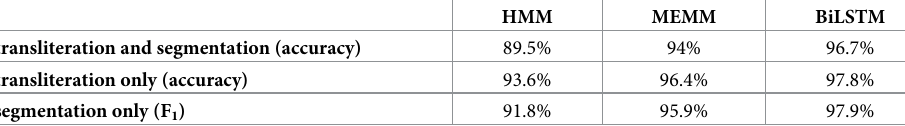
Table 2. Test accuracy for all